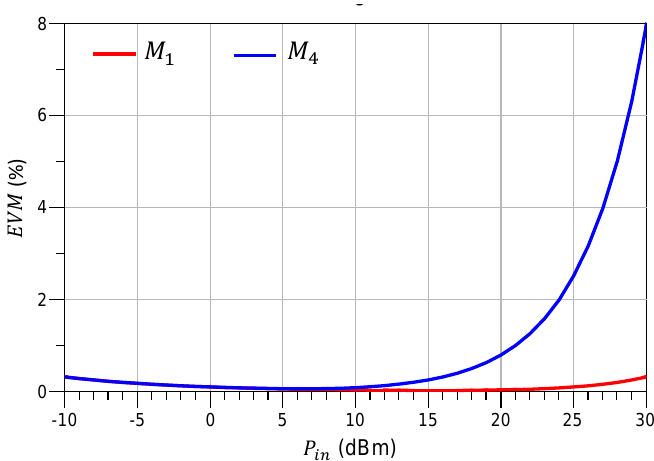
Figure 9. Error Vector Magnitude (EVM) of test reconfigurable